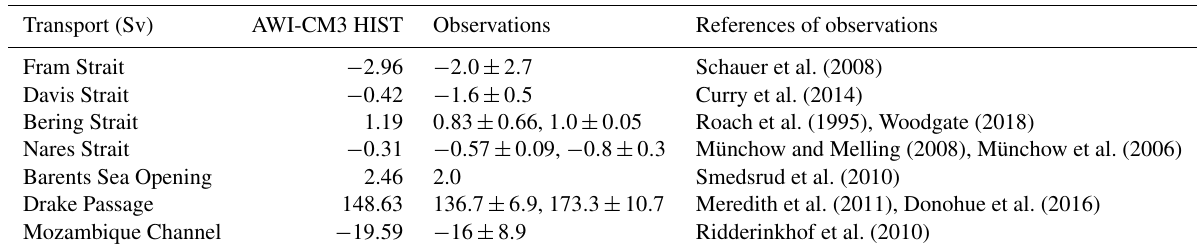
Table C2. Transport fluxes (Sv) through a number of straits and channels as simulated by AWI-CM3 in comparison to observational estimates. Analysis period was for 1990–2014 of the historic